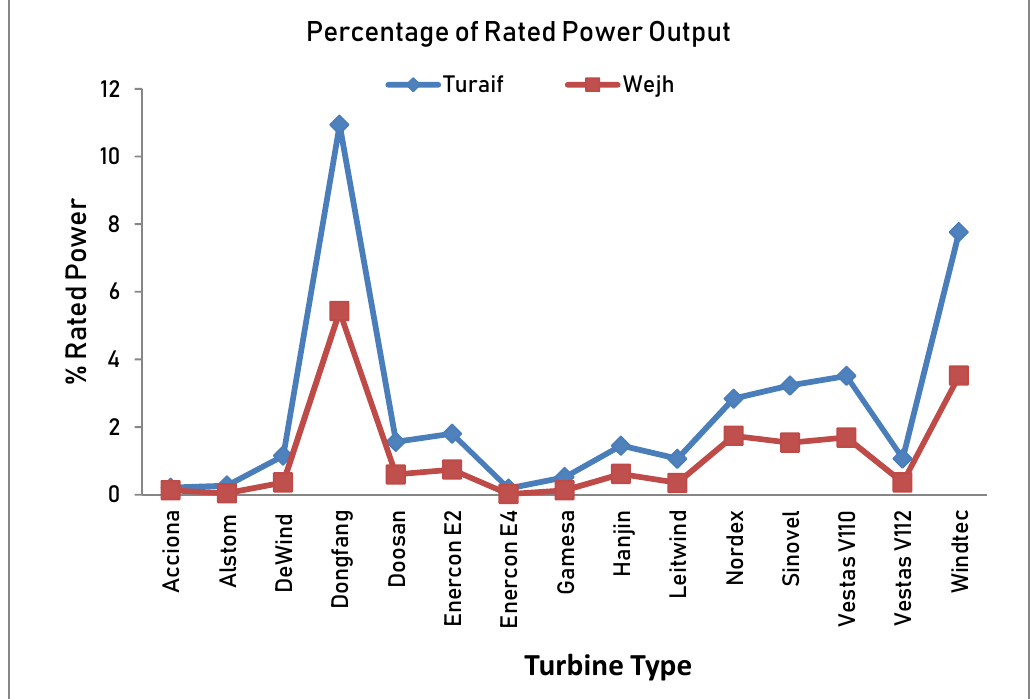
Figure 5. Comparison of RPO for different turbines for Turaif and Wejh.